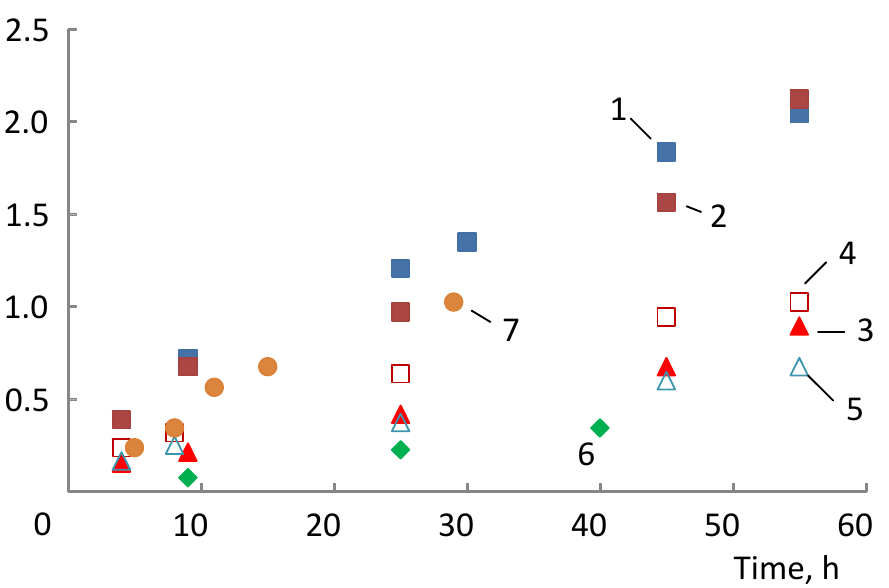
Figure 1. The kinetic plots for AN polymerization in DMSO at 60 °C. [AN] = 4 M. 1—